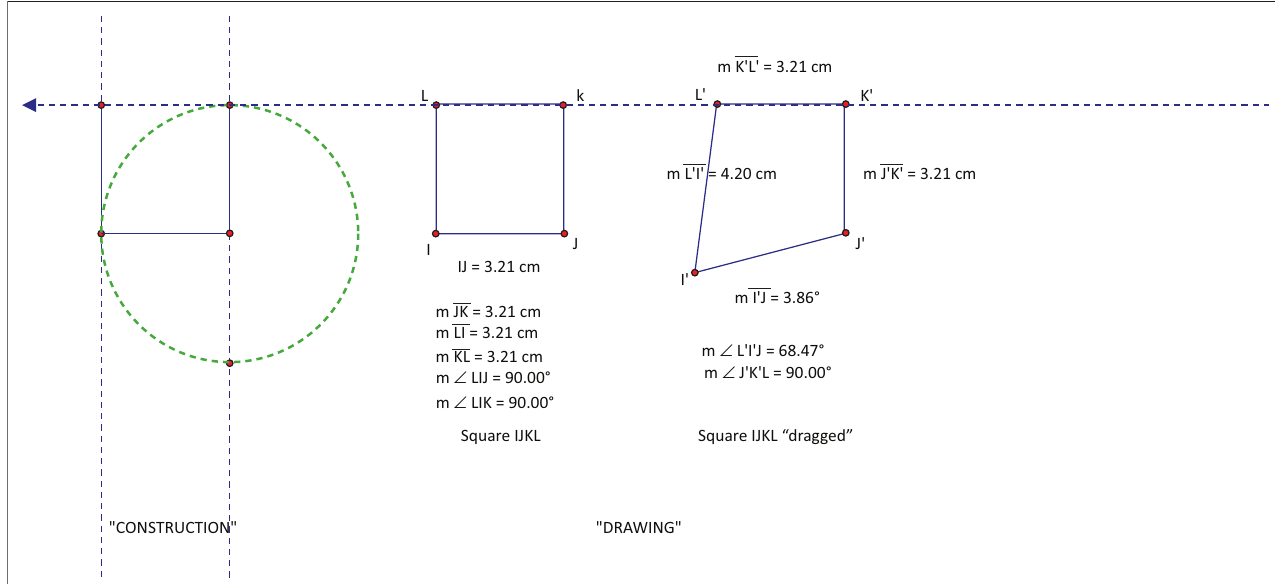
FIGURE 4: ‘Drawing’ vs. ‘construction’ of a square in Sketchpad